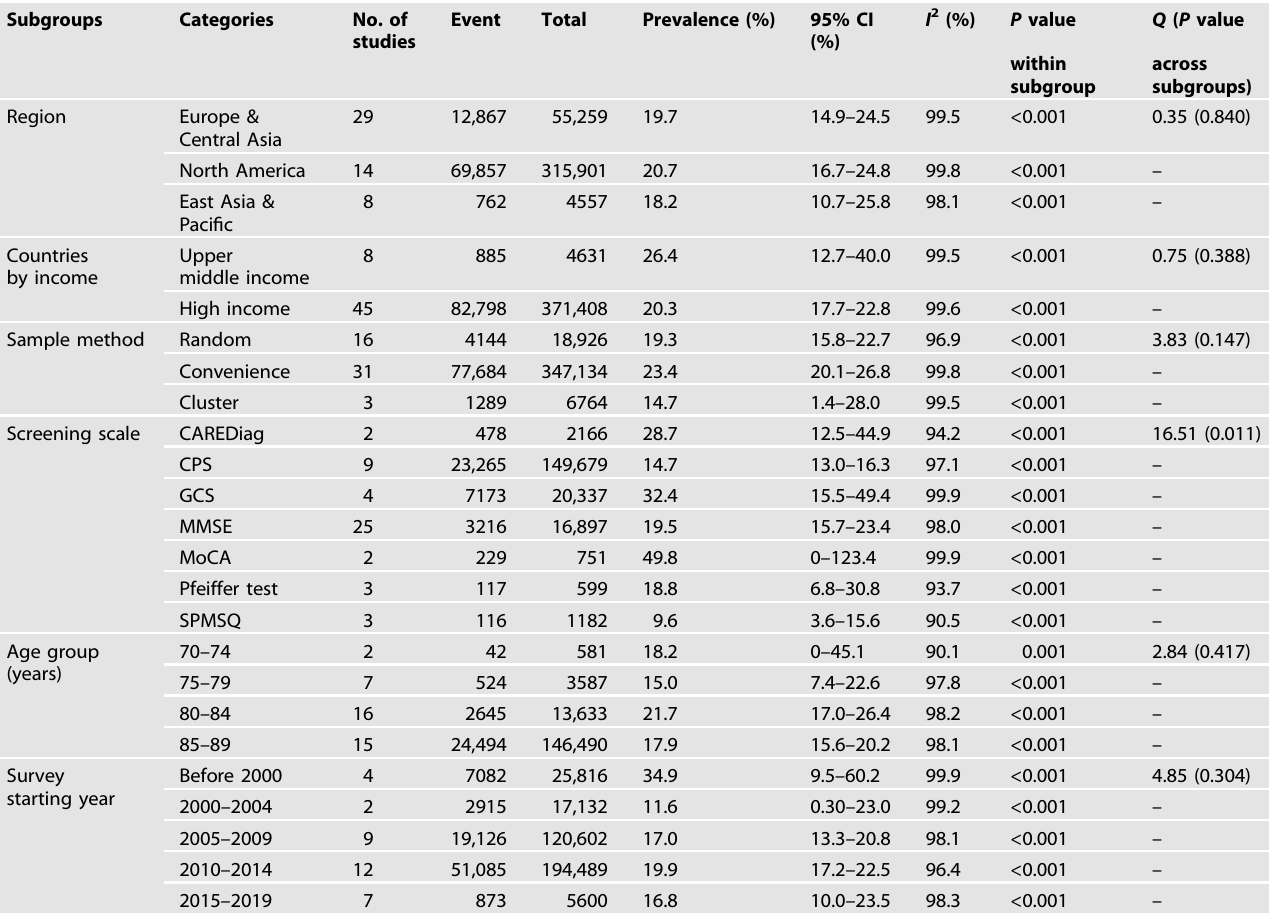
Table 2. Subgroup analysis of the prevalence of mild cognitive